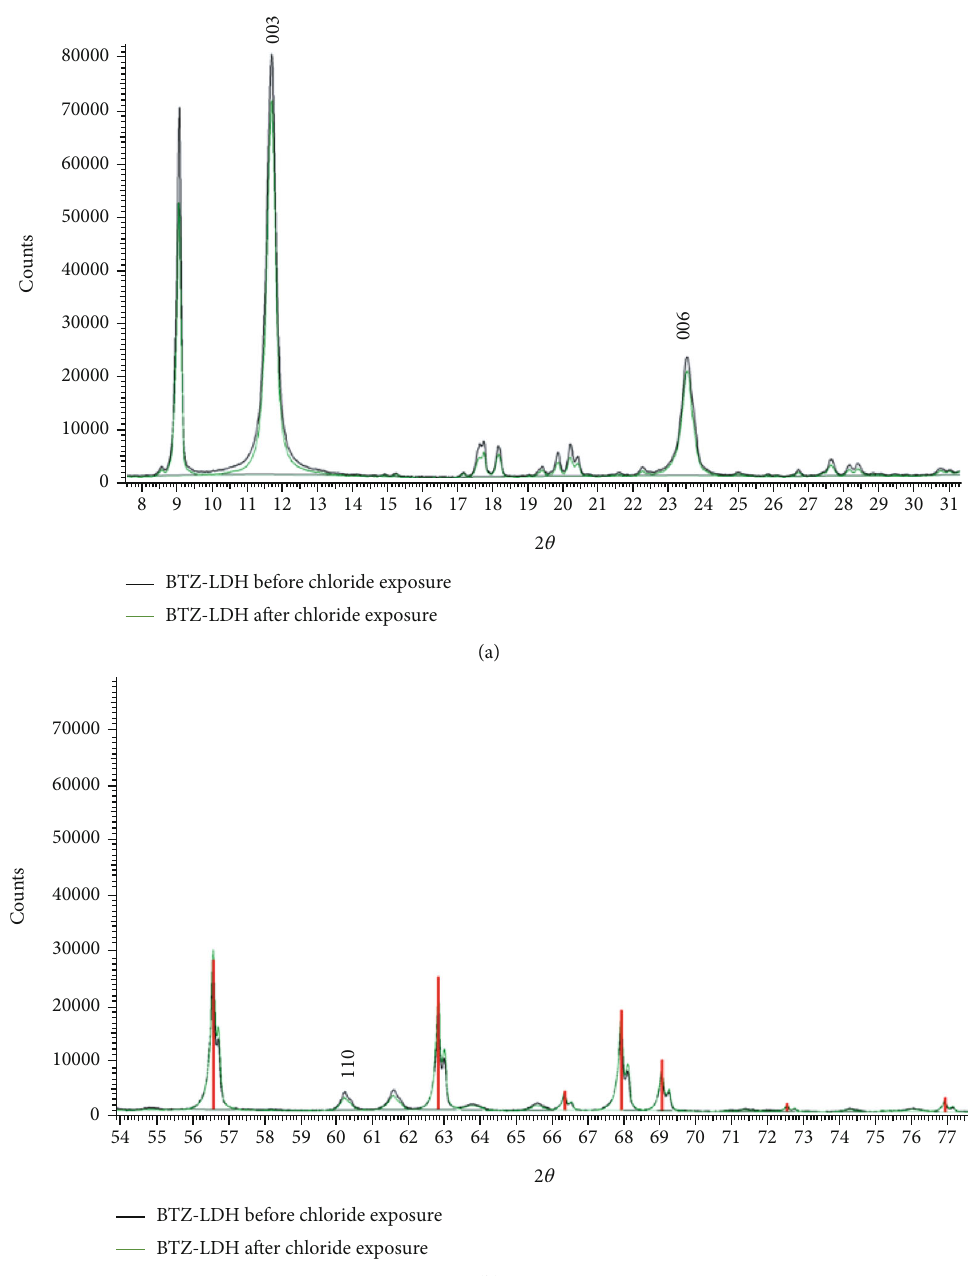
Figure 8: Di ff ractograms obtained for BTZ-LDH before (black) and after (green) exposure to 3.5% NaCl (a) region between 8 and 31 ° and (b) region between 54 and 77 ° . Peaks assigned with a red line are related to the standard ZnO added to the sample to the correction of peak